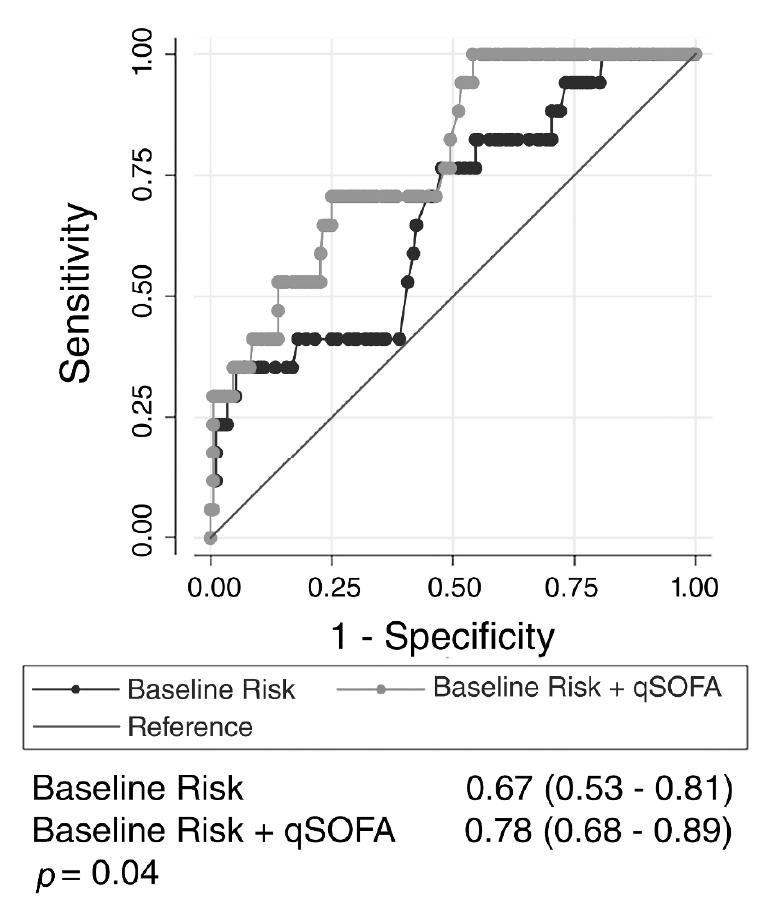
Figure 5. Receiver operating characteristic curves for patients with Staphylococcus aureus . Baseline risk compared to baseline risk added to quick sequential organ failure assessment (qSOFA) score. Baseline risk model includes age, sex, and co-morbidities associated with the